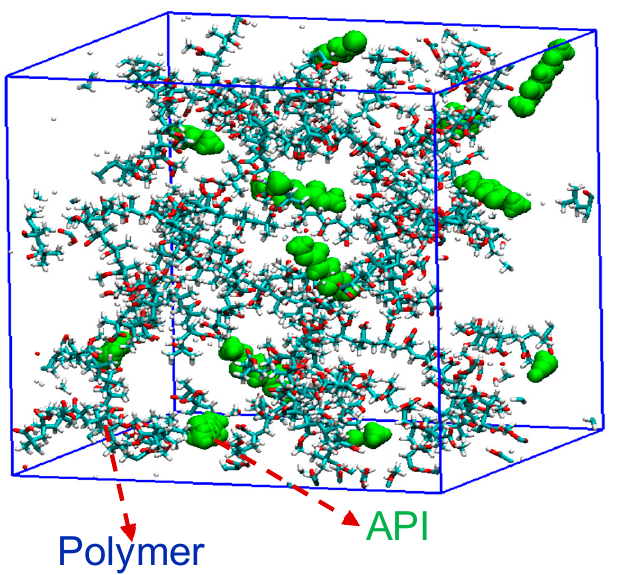
Figure 3. A representative simulation snapshot for the mixture of API molecules and polymeric excipient. The API molecules are shown in green.